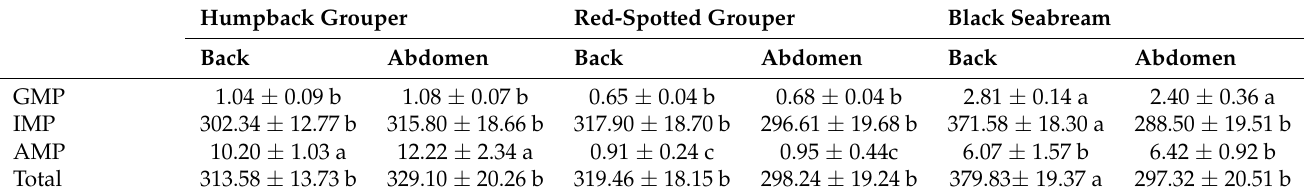
Table 4. The contents of 5 (cid:48) -nucleotides (mg/100 g of wet weight) of back and abdominal muscles in three perciform fishes.